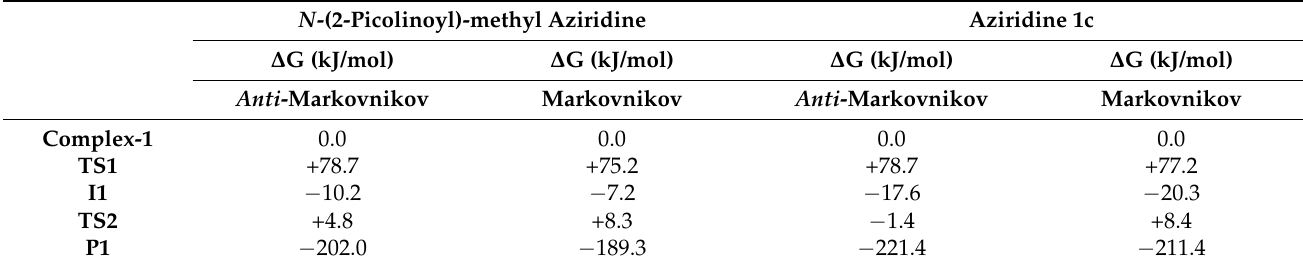
Table 3. Free energy for the regioselectivity of N -(2-picolinoyl)-methyl aziridine and 1c using the model in Scheme